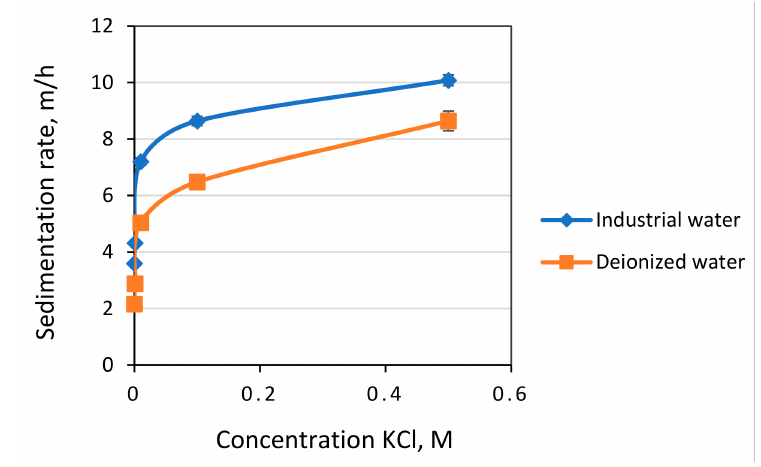
Figure 4. Sedimentation rate as a function of KCl concentration.